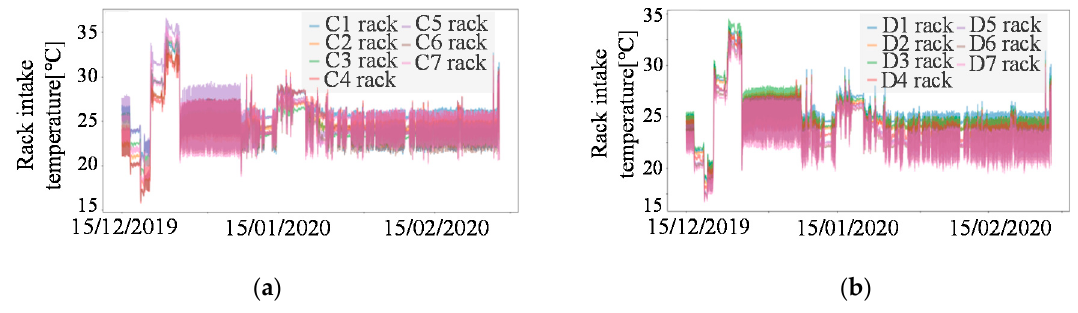
Figure 10. Time-series change of rack intake temperature in each rack row. ( a ) Rack intake temperature in C rack row. ( b ) Rack intake temperature in D rack row.